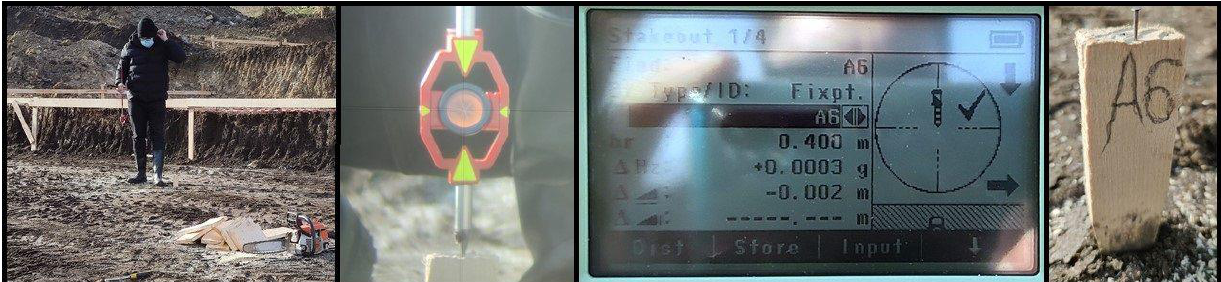
Figure 7. General workflow of a construction layout point marked on-site.